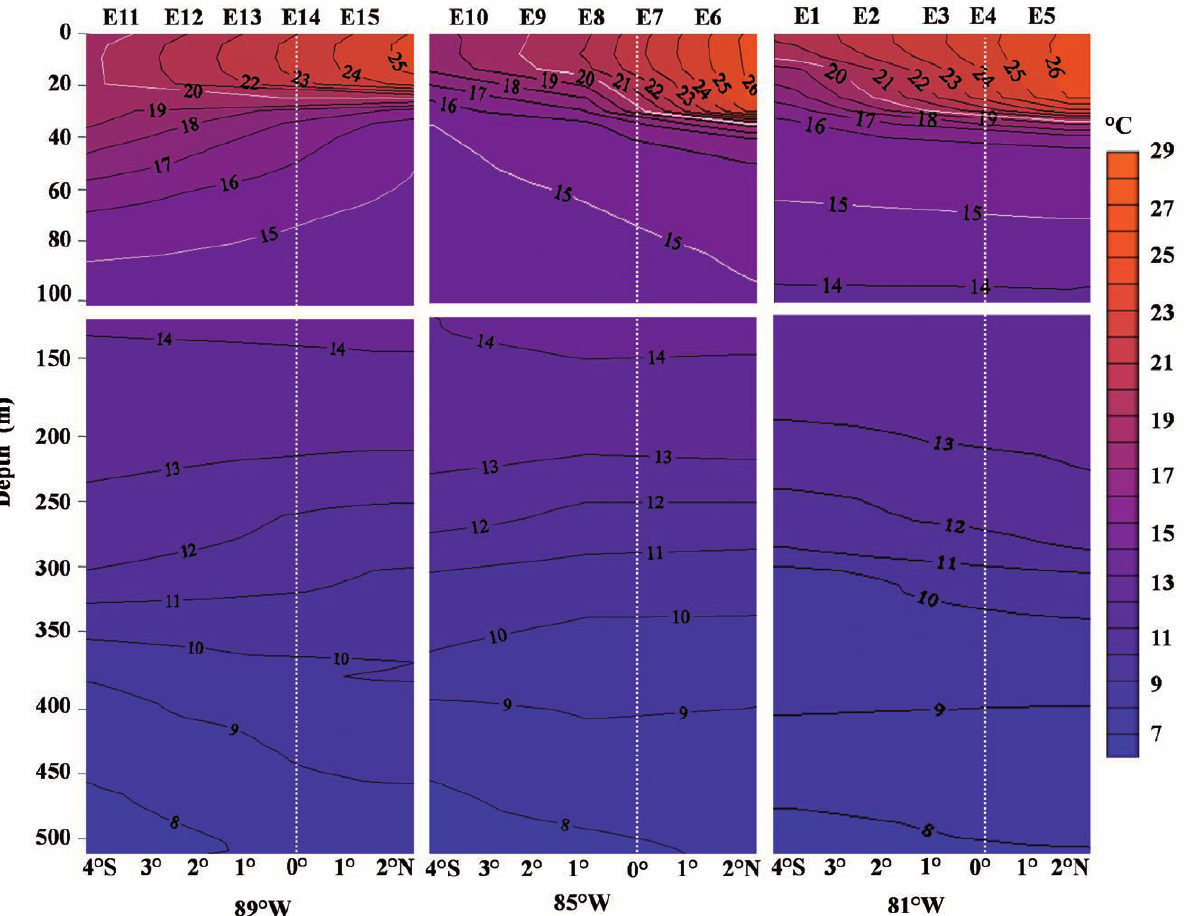
oceanic mesoscale eddies formed in the vicinity of the cruise track. Red lines are the inferred trajectories of the westward South Equatorial Current (1) and the eastward Equatorial Undercurrent (2) extended to the surface. Low reliability of geostrophic estimates near the coast and along the equatorial fringe has been masked by a white